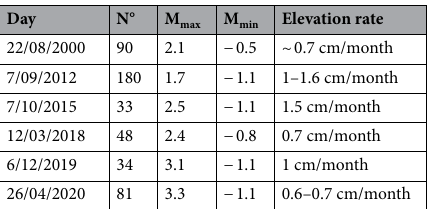
Table 1. Summary of the analyzed swarms: swarm occurrence day, number of detected earthquakes, maximum and minimum magnitude and elevation rate (from monthly or weekly bulletins of INGV).